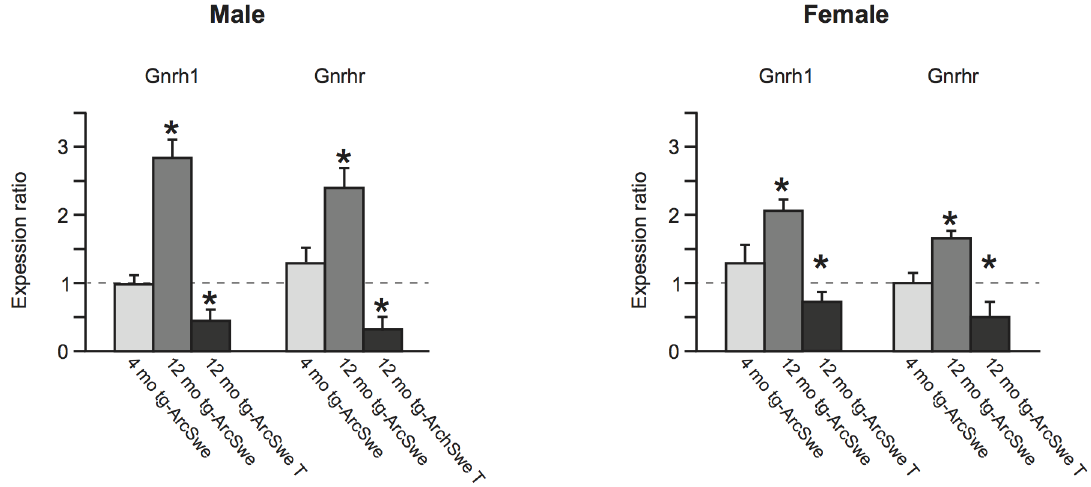
Figure 2. mRNA expression levels across the groups at 4 and 12 months. Hippocampal expression of Gnrh and Gnrhr transcripts in male and female tgArcSwe mice related to control groups. Data are represented as fold change (FC) and standard error mean (SEM). The fold change values are derived from relative quantification and normalization to the expression of two reference genes (B2m and Gusb). Genes with values higher than 1 indicate increased mRNA expression, values lower than 1 decreased mRNA expression in target group relative to control group. Light grey bars demonstrate the fold change value of gene expression in 4 months old tgArcSwe relative to age-matched WT-mice; Grey bars demonstrate the fold change value of gene expression level in 12 months old tgArcSwe relative to age-matched WT-mice. Black bars demonstrate the fold change values of gene expression in 12 months old Gnrh-a treated tgArcSwe relative to vehicle treated tgArcSwe. Both sexes are presented separately. Significant (Wilcoxon signed rank test, p , 0.05) changes in gene expression are indicated by asterisks.